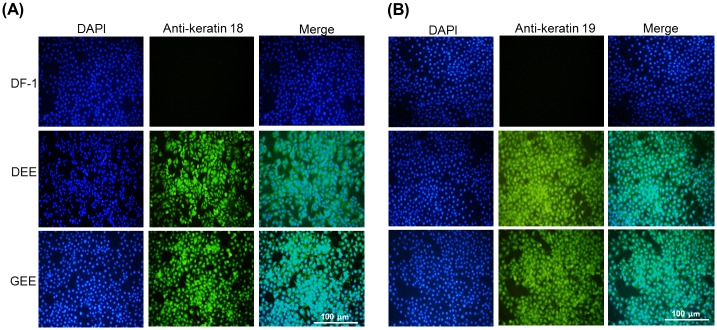
Expression of epithelial cell markers (keratin-18 and -19) in the established GEE cell line using IFA.Chicken fibroblast (DF-1) and Duck embryo epithelial (DEE) cells were used as a negative and a positive control, respectively. All of the respective cells were fixed with 3.7% formaldehyde and permeabilized with 0.5% Triton X-100 in PBS. Then, cells were stained separately either with mouse monoclonal anti-keratin 18 (panel; A) or 19 (panel; B) antibody specific to epithelial cells. Antibody binding was revealed with Alexa Fluor 488 goat anti-mouse IgG secondary antibody. Nuclei were stained with DAPI (Vector Laboratories).